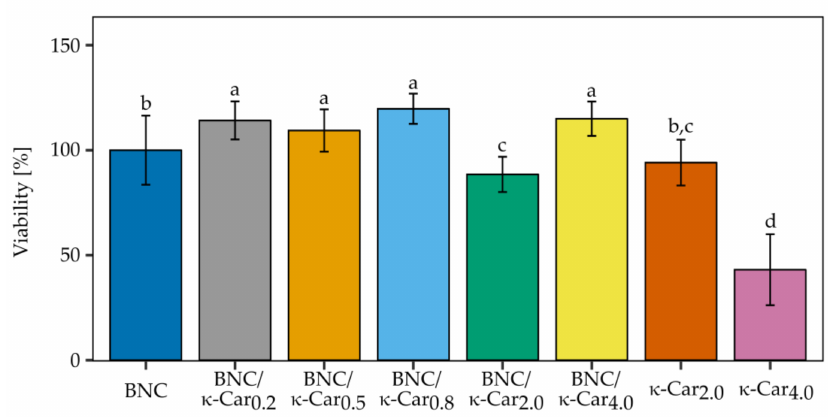
Figure 8. The viability of ATDC5 cells after 21 days of growing on the surface of BNC and BNC/ κ -Car composites. (The data are presented as the means ± SD from at least three independent experiments; the means that are marked with different letters are significantly